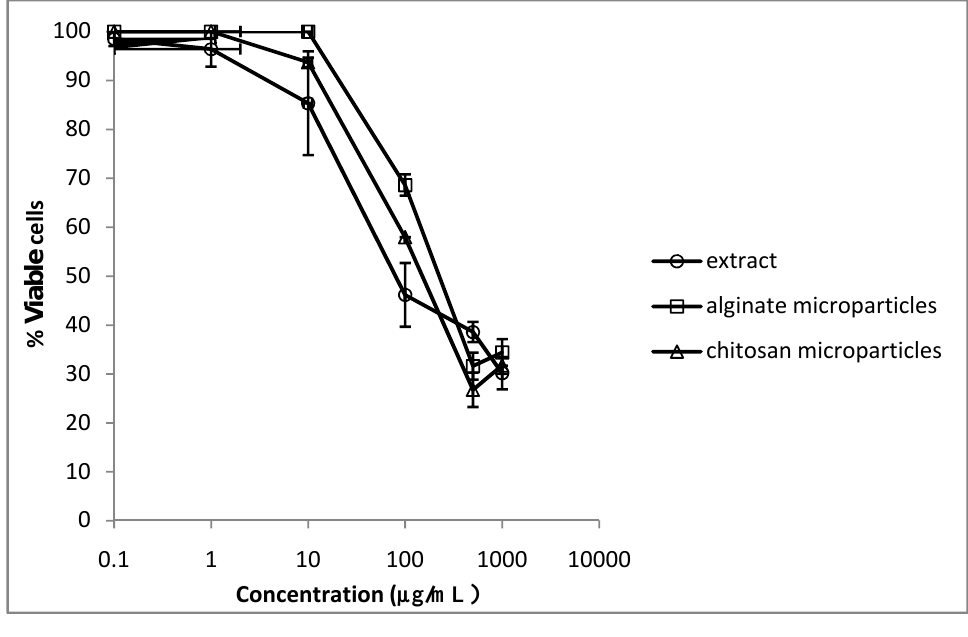
Figure 5. Cytotoxicity assay. Percentage of viable cells after 48 h of incubation with pomegranate extract, pomegranate extract-loaded alginate microparticles and pomegranate extract-loaded chitosan